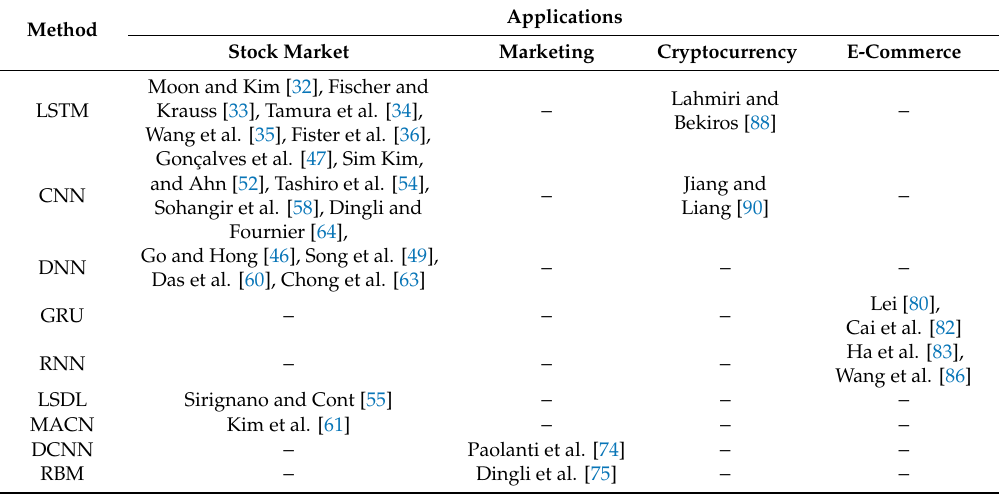
Table 8. List of single deep learning methods employed in economics related